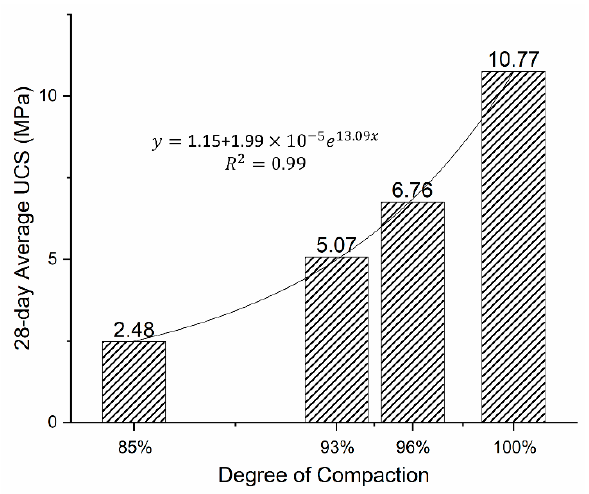
Figure 3. Effects of degree of compaction on the unconfined compressive strength.